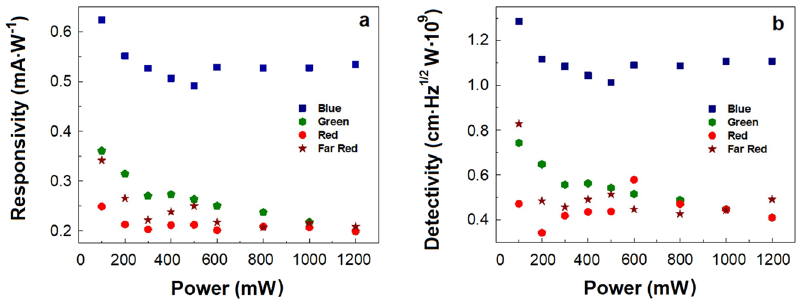
Fig. 9 Photoelectrochemical performance of TaS 2 -integrated photodetector. The responsivity ( a ) and speci fi c detectivity ( b ) of TaS 2 - integrated PD in 0.5 M H 2 SO 4 solution as a function of power upon four different illumination wavelengths: blue, green, red, and